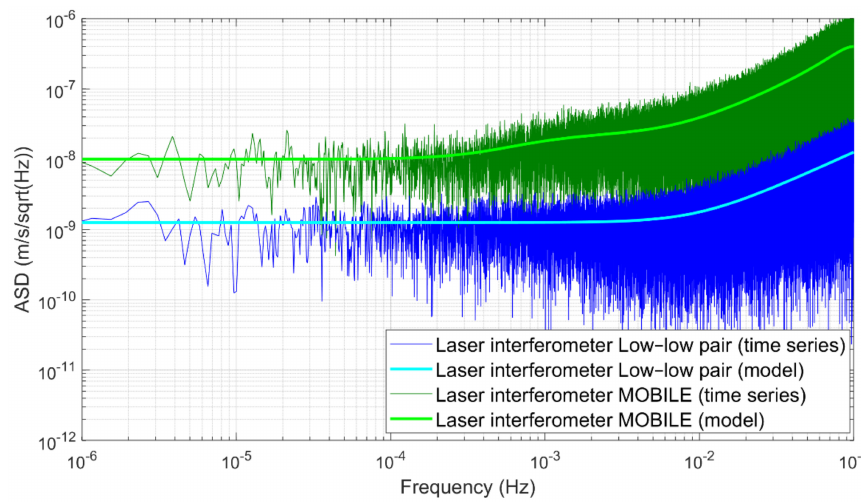
Figure 3. Amplitude spectral density (ASD) of the relative distant measurement errors in terms of range-rates for the low–low pair formation (dark blue) and for MOBILE (dark green). The generation of the noise time-series was done by scaling the spectrum of normally distributed random time-series with their individual spectral model (light blue and light green